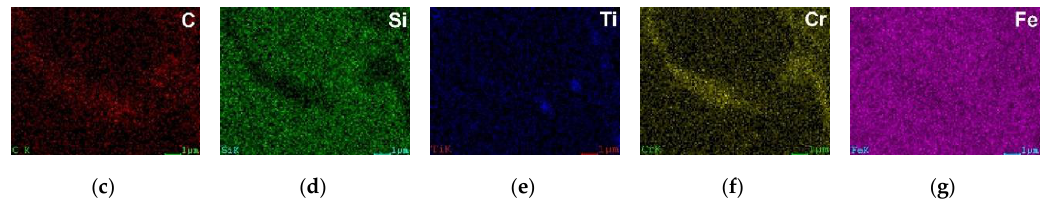
Figure 8. ( a,b ) SEM micrographs taken from the mid-section of the TRC (Table 3) showing eutectic- like structures due to the last solidification stages, ( b ) detail from ( a ), and ( c – g ) EDS maps of C, Si, Ti, Cr, and Fe distributions respectively, from ( a ).